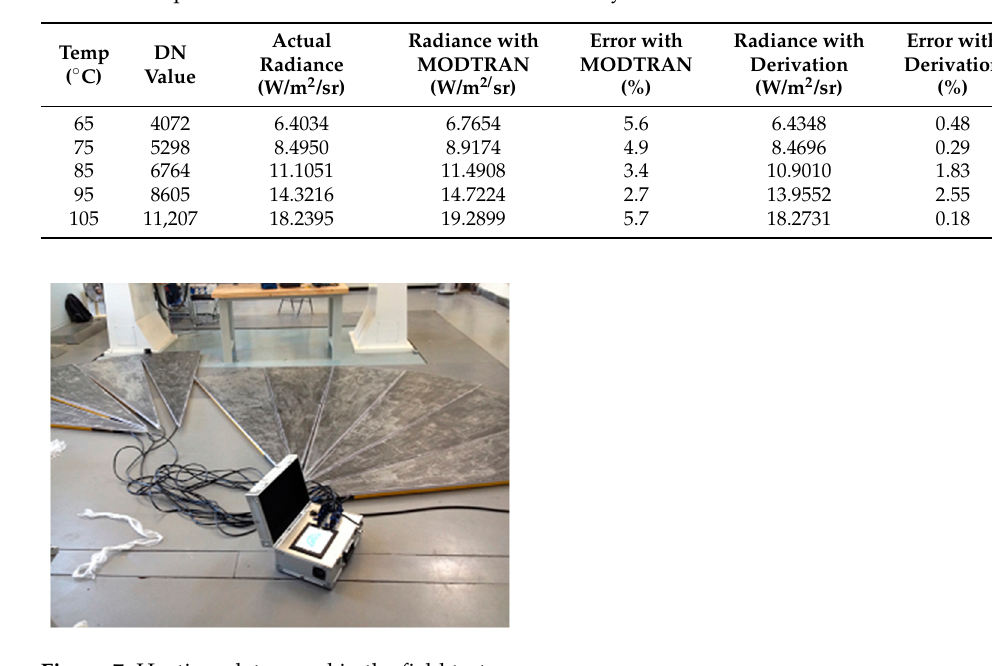
Table 6. Comparison of inversion results for the blackbody source.